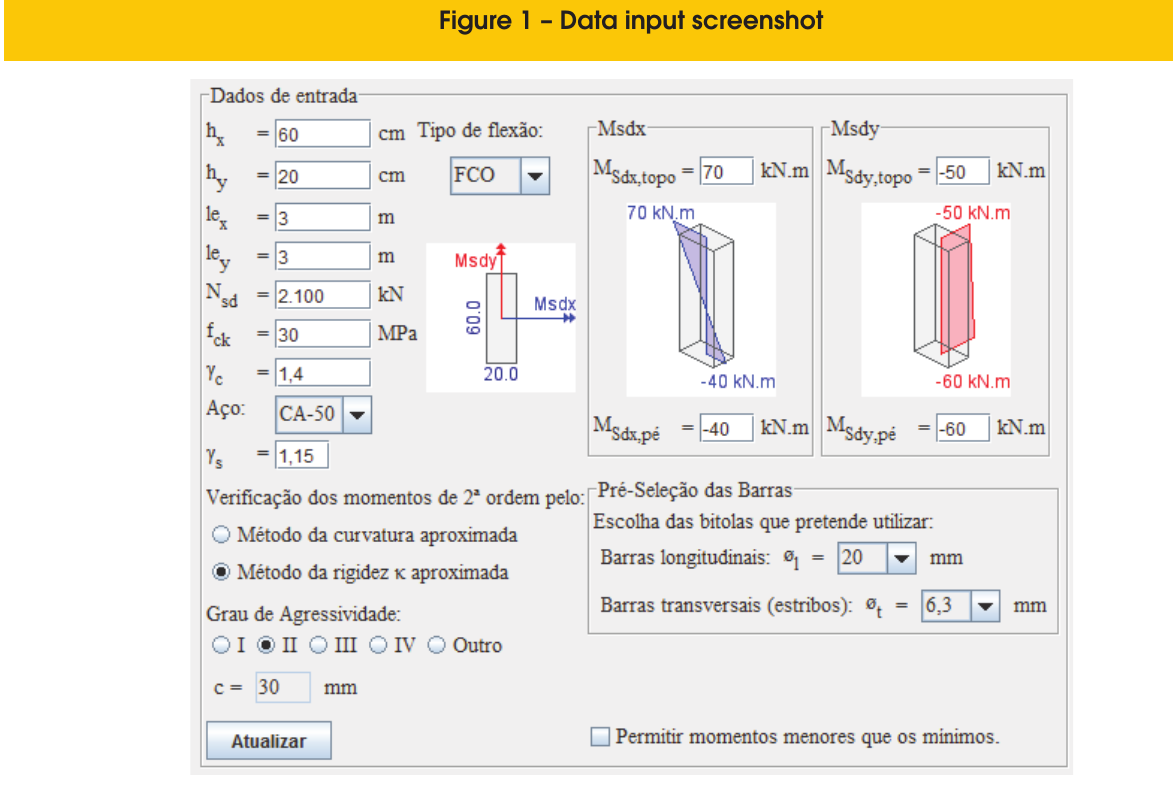
Figure 1 – Data input